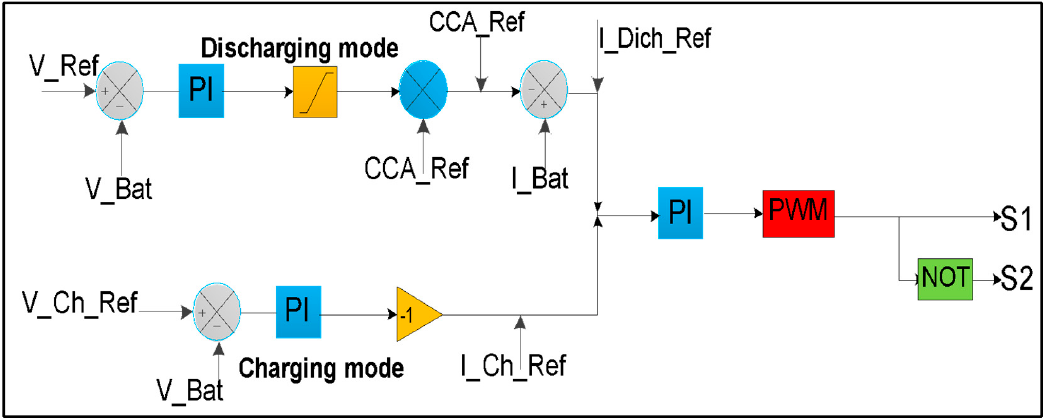
Figure 8. Charging and discharging control using triple-loop PI control.